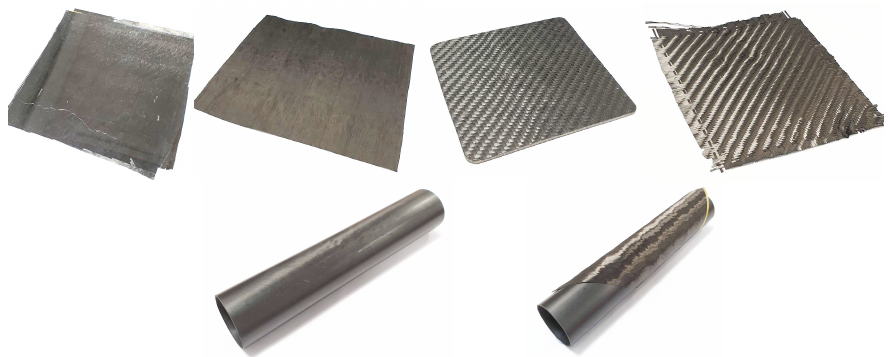
Figure 6. ( Top ): Photographs of the four planar samples: from left, these are Cured UD, dry UD, cured woven and dry woven. ( Bottom ): Tubular samples: from left, these are cured UD and dry UD. The dry UD tube simply comprises the cured piece wrapped in dry UD